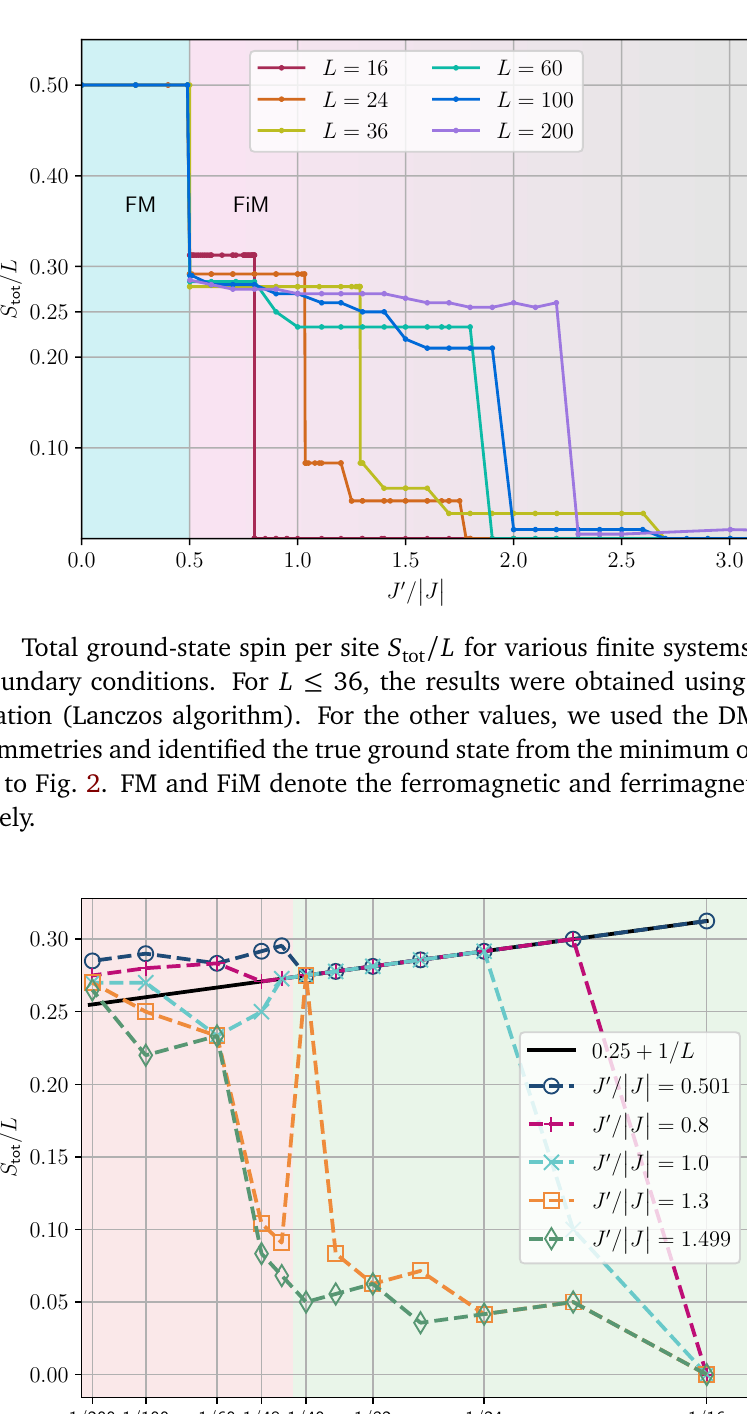
Figure 4: The same as Fig. 3 but plotted as a function of the inverse system size L − 1 for various values of J ′ / | J | . The curve f ( L − 1 ) = 0.25 + L − 1 is shown for comparison. (cid:12) (cid:12) For small J ′ / (cid:12) J (cid:12) , the points collapse to f ( L but this is not the case for larger L or larger J ′ /